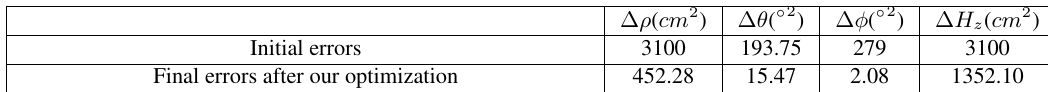
Table 15. Final errors of the intrinsic parameters of real point cloud